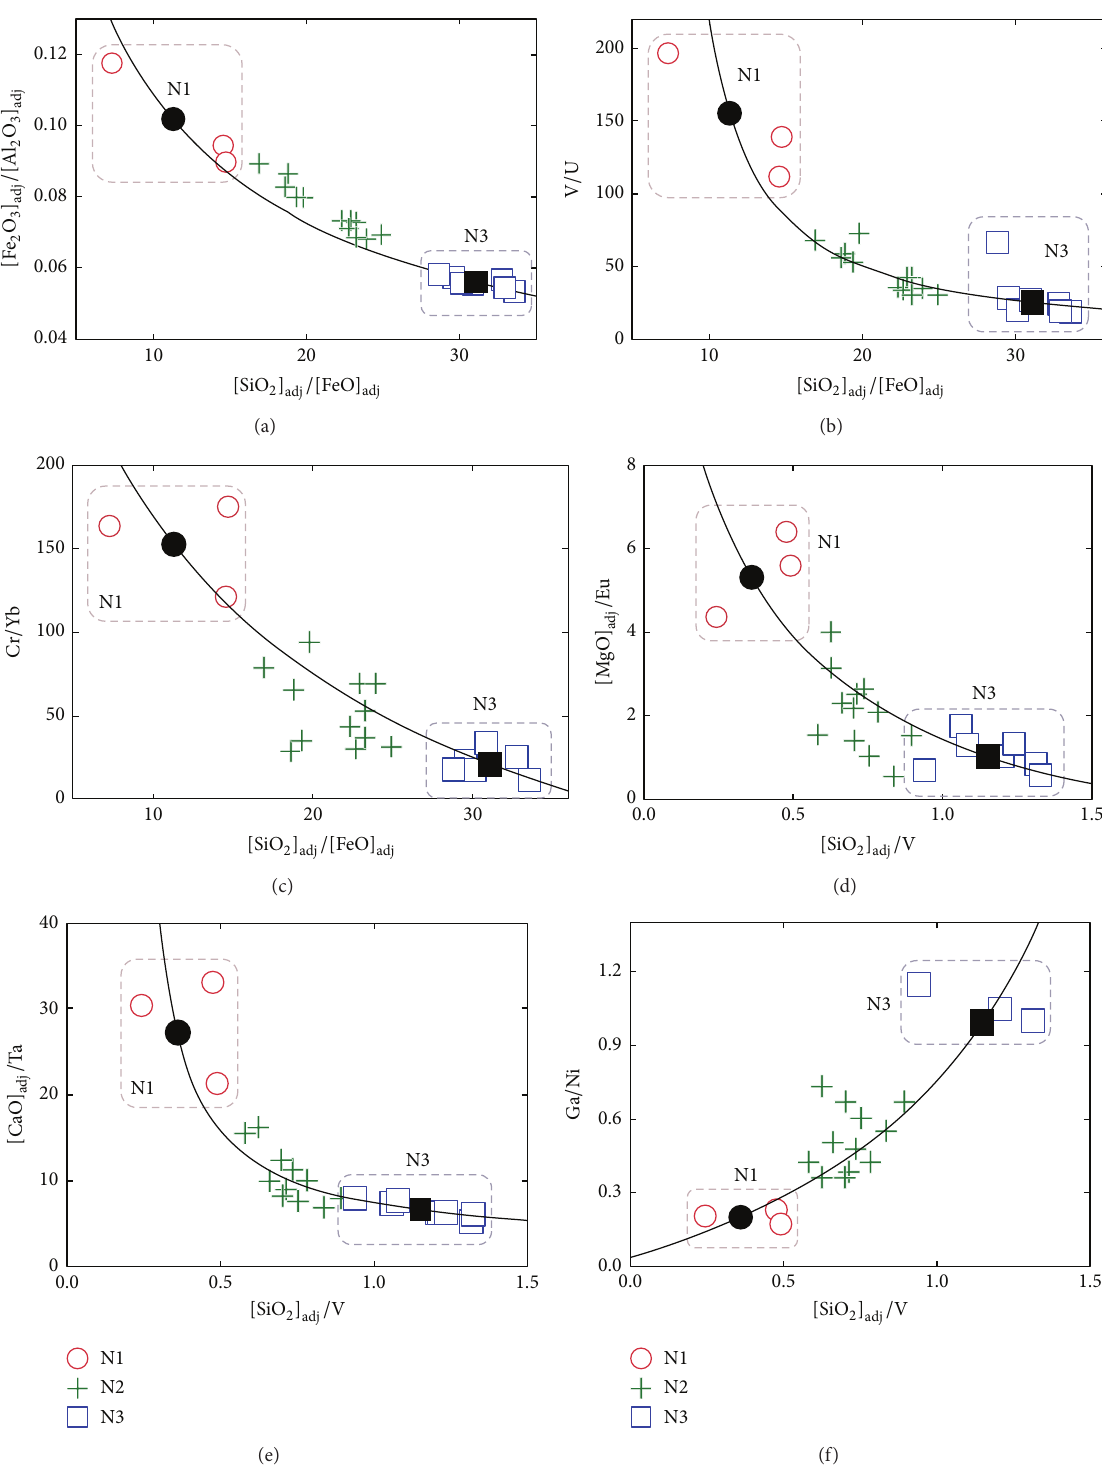
) and average felsic N3 lavas (black filled square, 𝐹 SC /[ FeO ] ; (c) Cr/Yb −[ SiO 2 ] adj adj